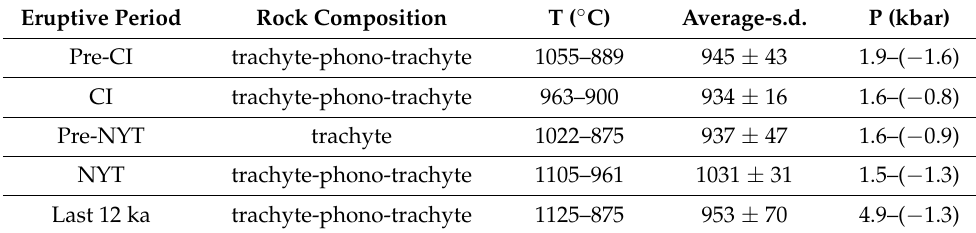
Table 6. Temperature and pressure output obtained from the Masotta et al. [30] geothermobarometers applied to clinopyroxene-melt couples whose equilibrium has been verified with the equilibrium test 2.